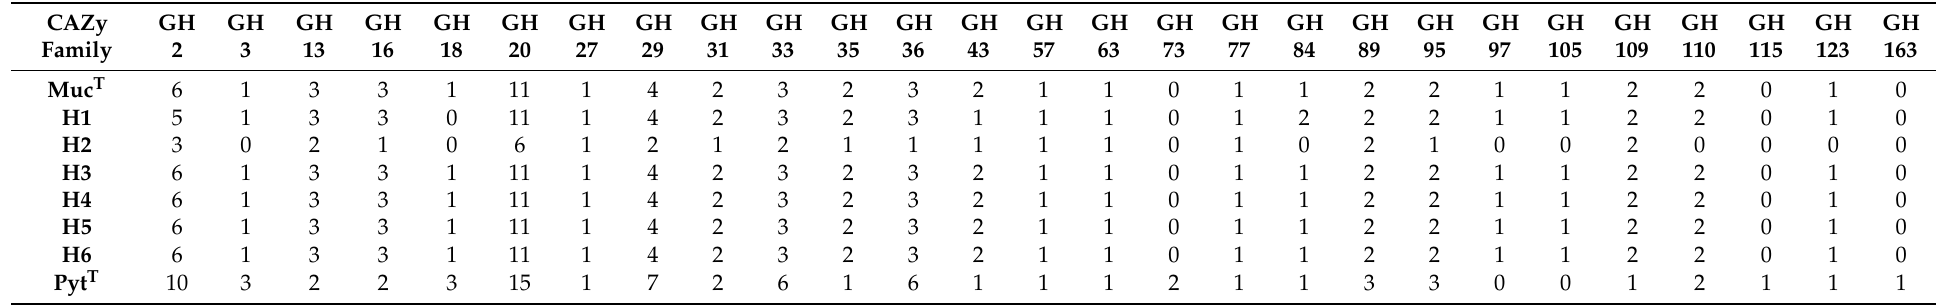
Table 2. Family classification of predicted glycoside hydrolases (GH) in the human isolates of Akkermansia muciniphila. The non-human isolate A. glycaniphila strain Pyt T was also included in the